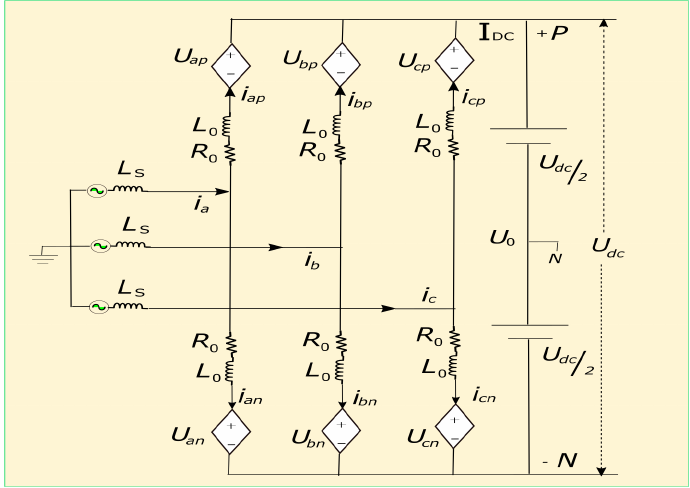
Figure 7. Equivalent circuit of